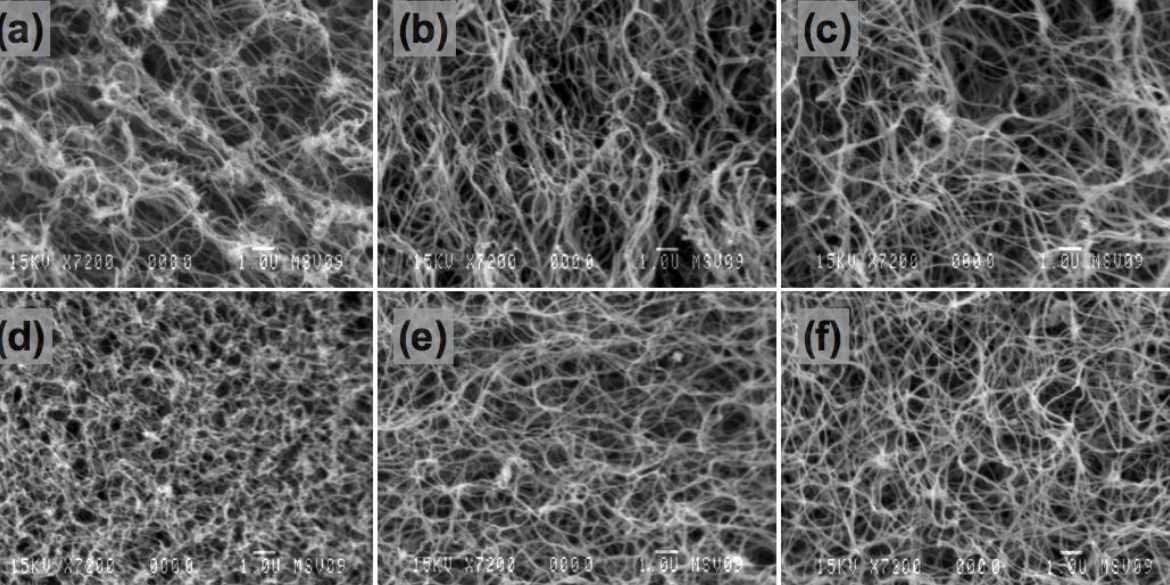
Table 2. Results from the turbidity measurements as a function of pH (7, 10), ionic strength (c1, c2, c3, c4, c5, c6, c7) and temperature (T1 = 4 °C, T1* = 4 °C and 21 °C after 38 days, T2 = 21 °C, T3 = 37 °C): Final absorbance for all the types of gels and t for gels prepared at pH